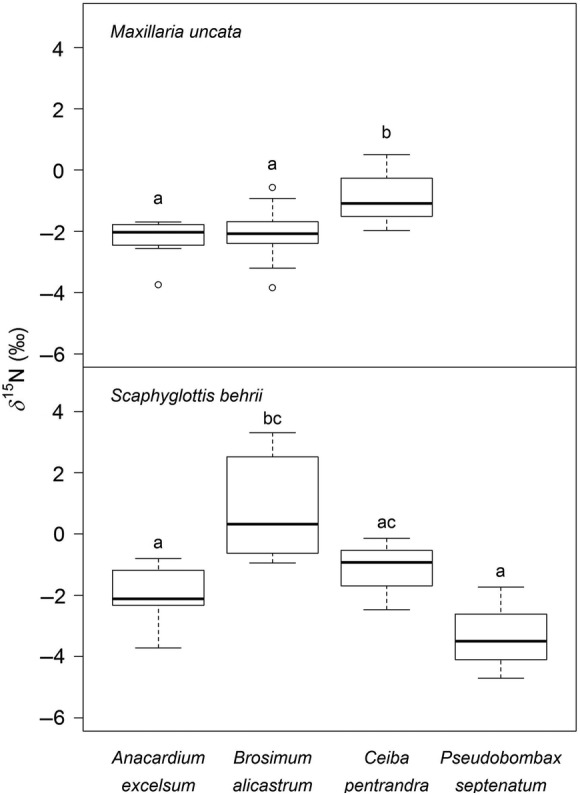
δ15N values for Maxillaria (38) and Scaphyglottis (28) sampled in different tree crowns. Letters indicate significant differences (ANCOVA with plant size as the covariate: Maxillaria P < 0.05, F(1,33) = 15.3; ANOVA: Scaphyglottis P < 0.05, F(3,23) = 13.9).